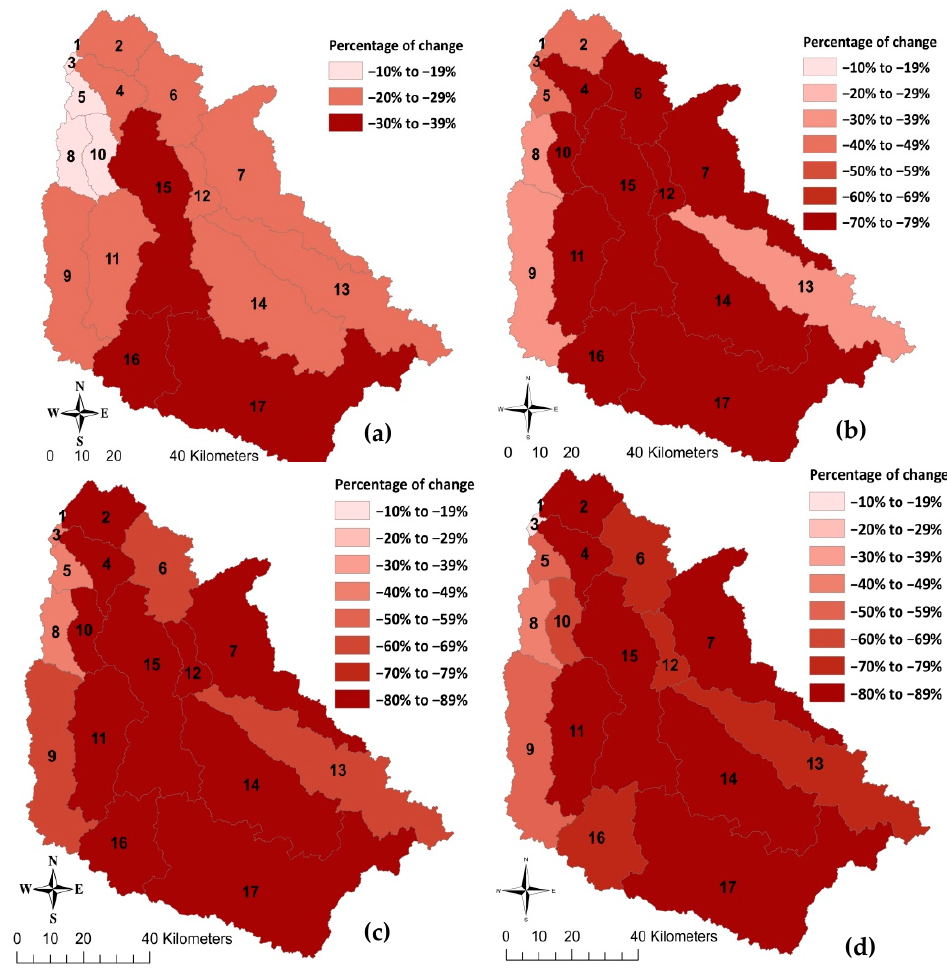
Figure 13. Water yield changes (to baseline average) by sub-basin during the dry years: ( a ) 2049–2050 under RCP4.5, ( b ) 2045–2046 under RCP8.5, ( c ) 2098–2099 under RCP4.5, and ( d ) 2097–2098 under RCP8.5.